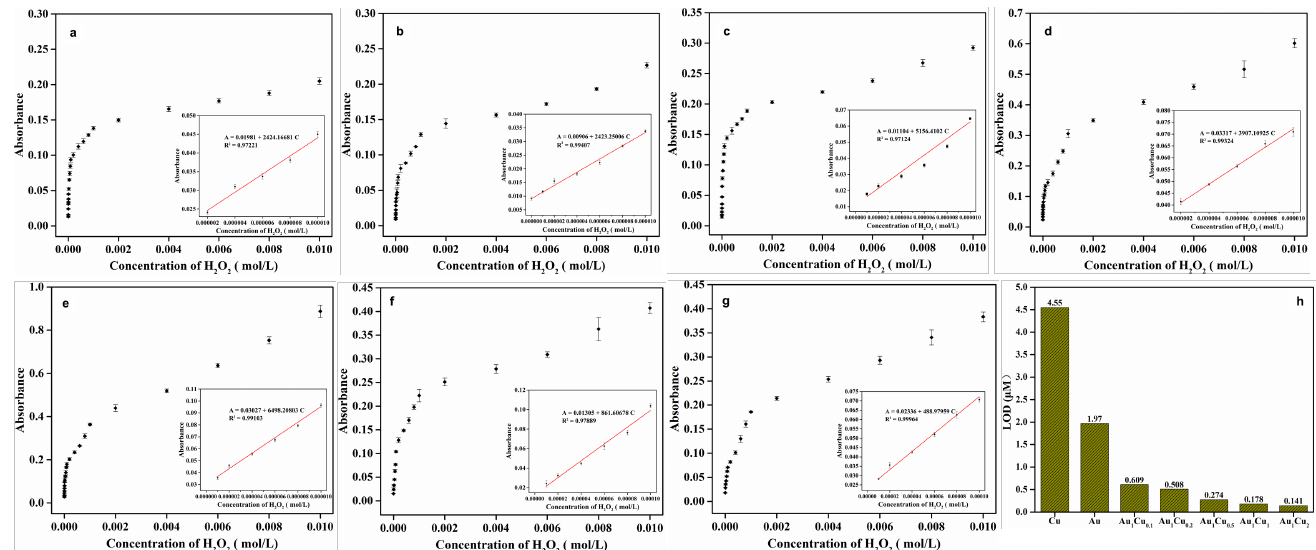
Figure 5. (a–g) Dose-response curves for H 2 O 2 detection using (a) Au 1 Cu 0.1 , (b) Au 1 Cu 0.2 , (c) Au 1 Cu 0.5 , (d) Au 1 Cu 1 , (e) Au 1 Cu 2 , (f) Cu, and (g) Au as peroxidase mimetics. Inset of a–e: Linear range of absorbance intensity Figure 5. ( a – g ) Dose-response curves for H 2 O 2 detection using ( a ) Au 1 Cu 0.1 , ( b ) Au 1 Cu 0.2 , ( c ) Au 1 Cu 0.5 , ( d ) Au 1 Cu 1 , versusH 2 O 2 concentration.(h)Limitofdetection(LOD)forH 2 O 2 ofAu 1 Cu 0.1 ,Au 1 Cu 0.2 ,Au 1 Cu 0.5 ,Au 1 Cu 1 ,Au 1 Cu 2 nanoparticles,CunanoparticlesandAunanoparticles. ( e ) Au 1 Cu 2 , ( f ) Cu, and ( g ) Au as peroxidase mimetics. Inset of ( a )–( e ): Linear range of absorbance intensity versus H 2 O 2 concentration. ( h ) Limit of detection (LOD) for H 2 O 2 of Au 1 Cu 0.1 , Au 1 Cu 0.2 , Au 1 Cu 0.5 , Au 1 Cu 1 , Au 1 Cu 2 nanoparticles, Cu nanoparticles, and Au